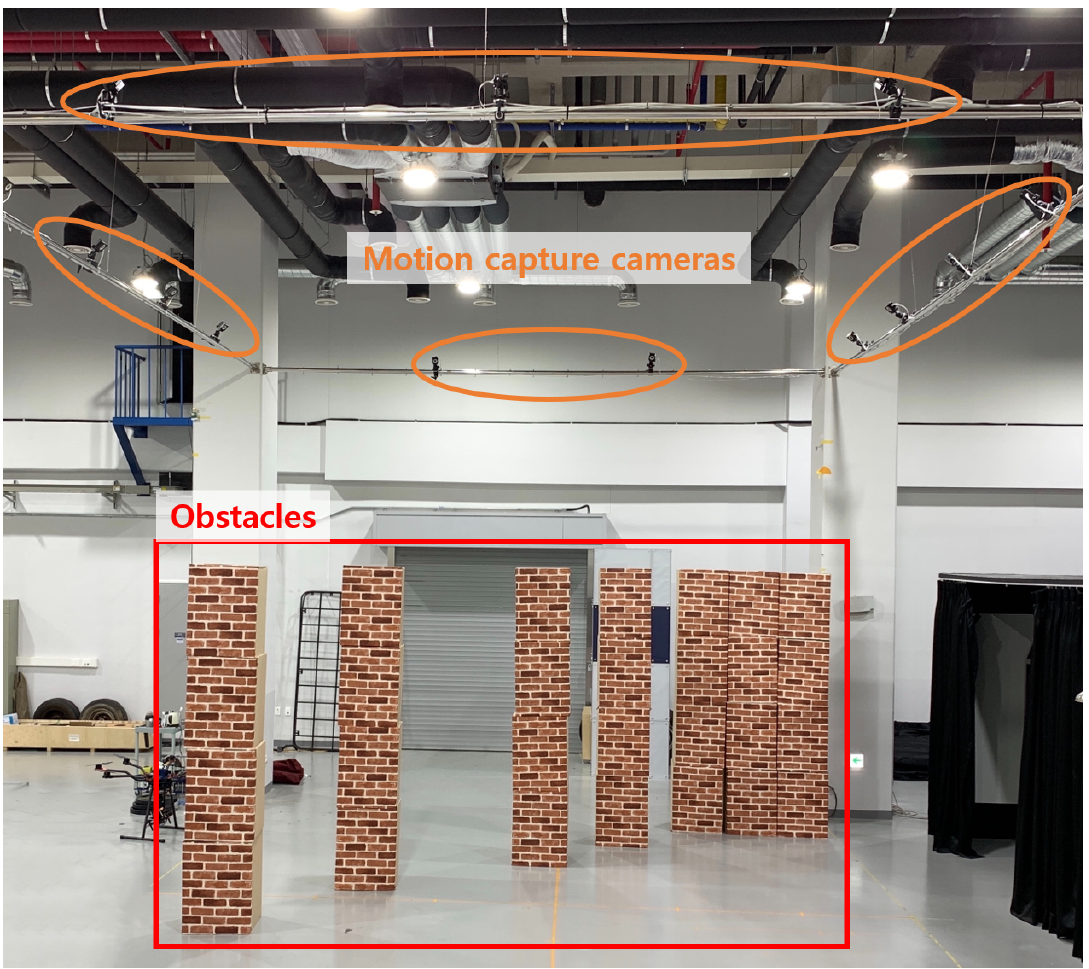
Figure 16. A sample environment for indoor